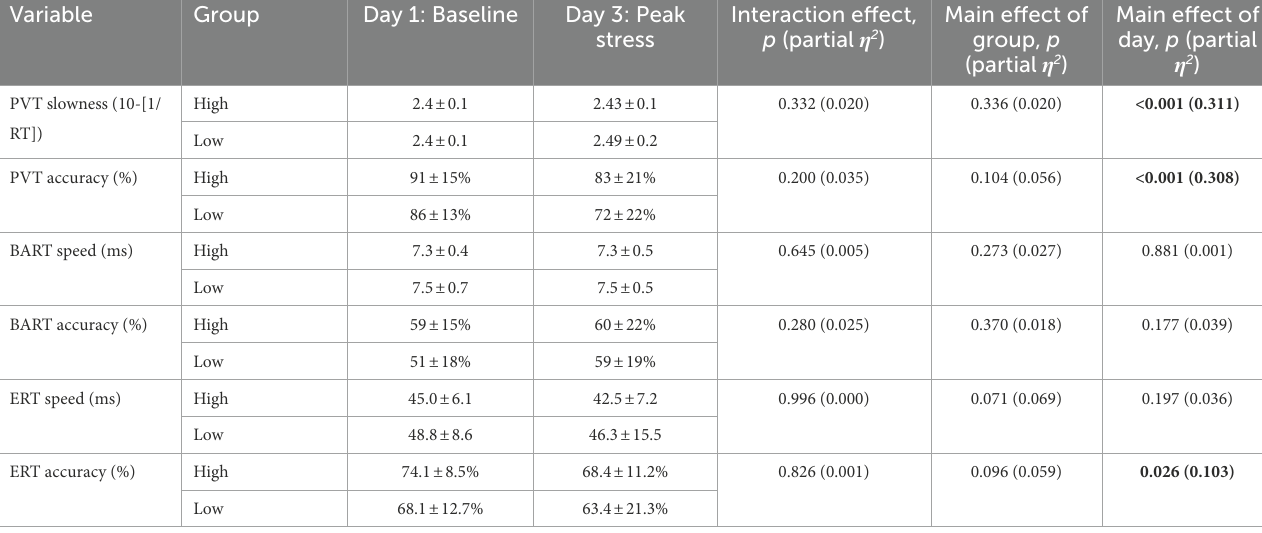
TABLE 5 Cognition test batteries stratified by low and high adaptability at baseline and peak stress.